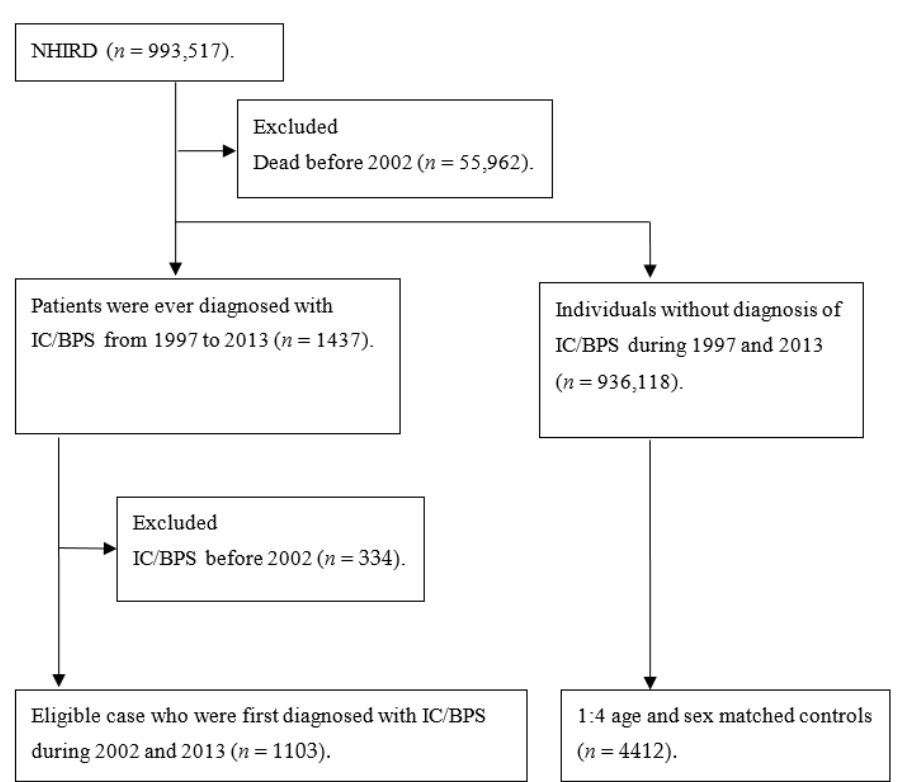
Figure 1. Flow chart of selection of study population in the nested case-control design: NHIRD, National Health Insurance Research Datasets; IC/BPS, interstitial cystitis/bladder pain syndrome.